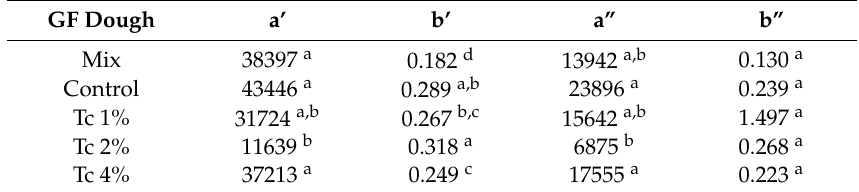
Table 3. Frequency dependence of G’ and G” described by the power-law parameters. Mix, Control and GF dough with T. chuii Tc 1%, Tc 2% and Tc 4%. Di ff erent letters in the same column correspond to significant di ff erences ( p < 0.05). R 2 > 0.91.